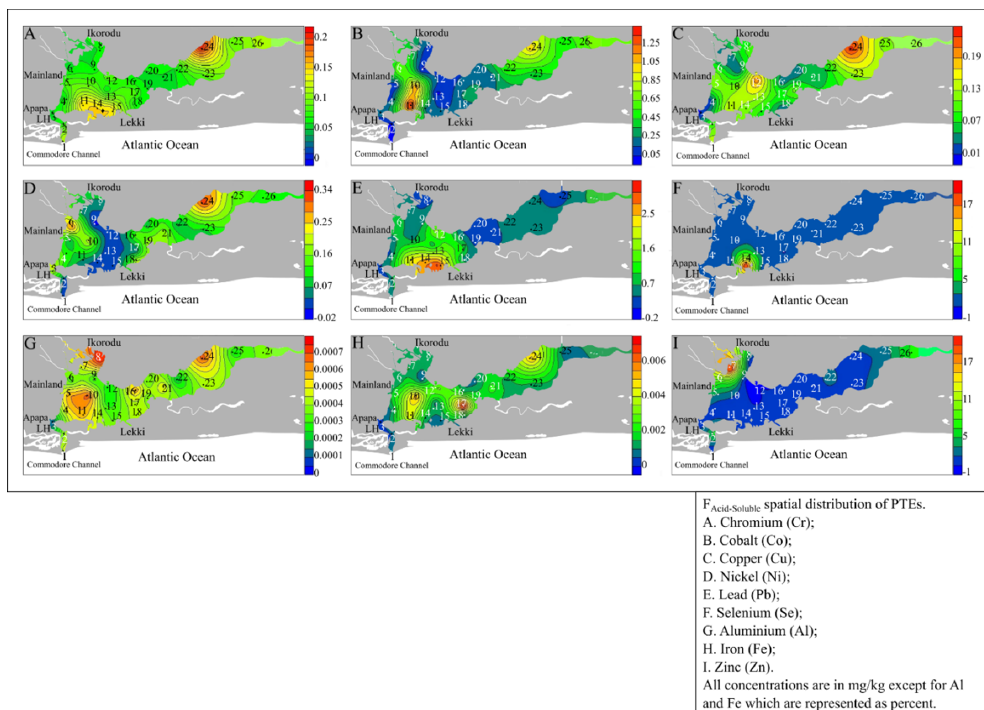
Figure A2. Acid-soluble fractions heat maps.